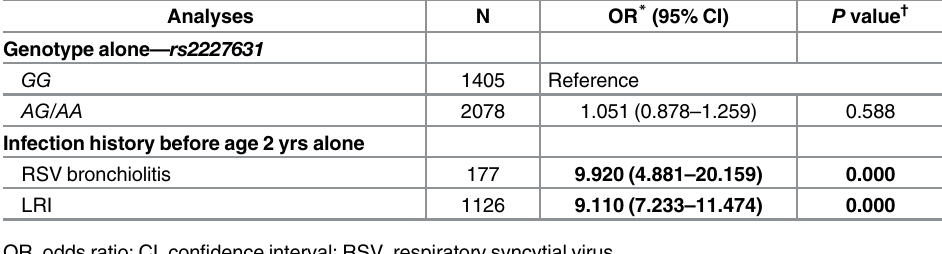
Table 2. Adjusted effects of rs2227631 , and infection on